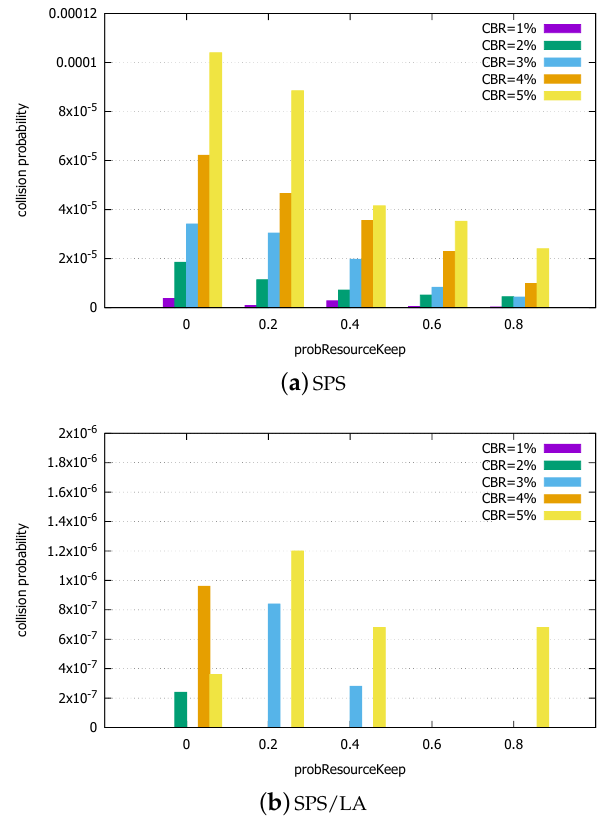
Figure 9. Collision probabilities under varying probResourceKeep , light load. ( a ) SPS. ( b ) SPS/LA.